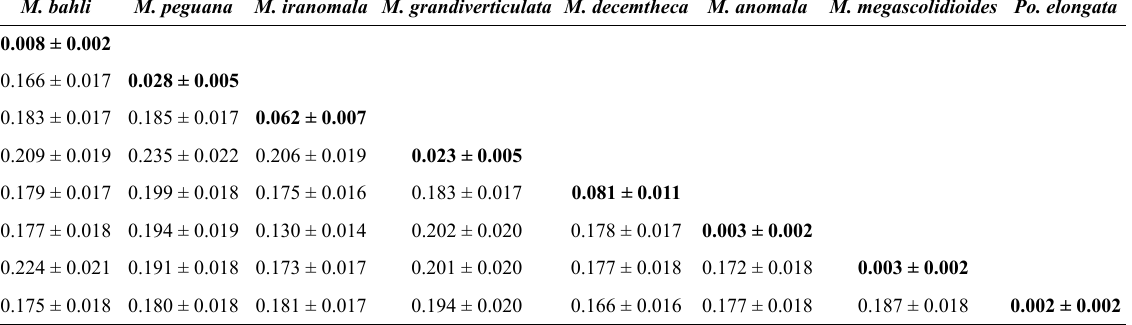
Table 4. The K2P intra- and interspecific genetic distances between Metaphire species using the 609 bp COI fragment. The intraspecific distances are in